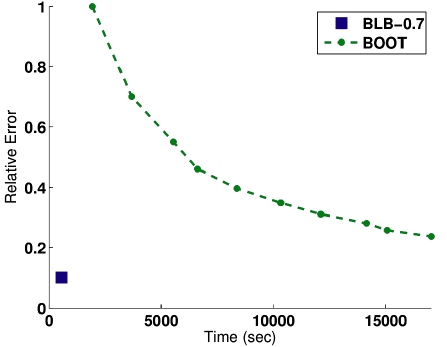
Figure 10. Parallelized results on the entire dataset. b = n 0.7 , s = 5 and r = 50 is used for BLB. For BOOT, s grows over